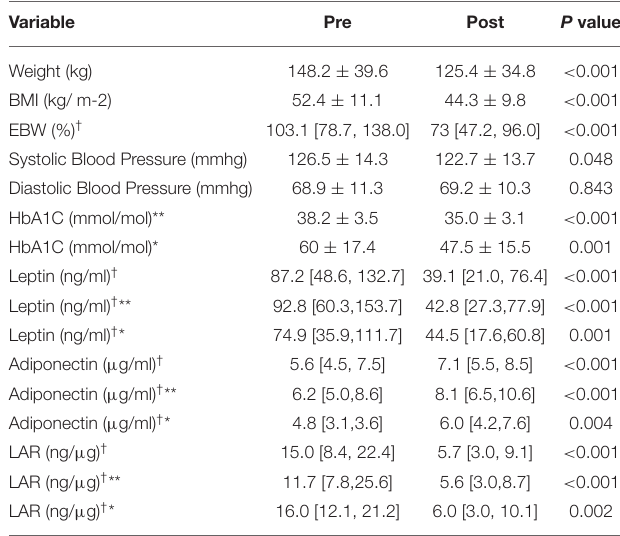
TABLE 1 | Changes in anthropometric variables, leptin, adiponectin and the LAR after completion of the milk-based LELD.